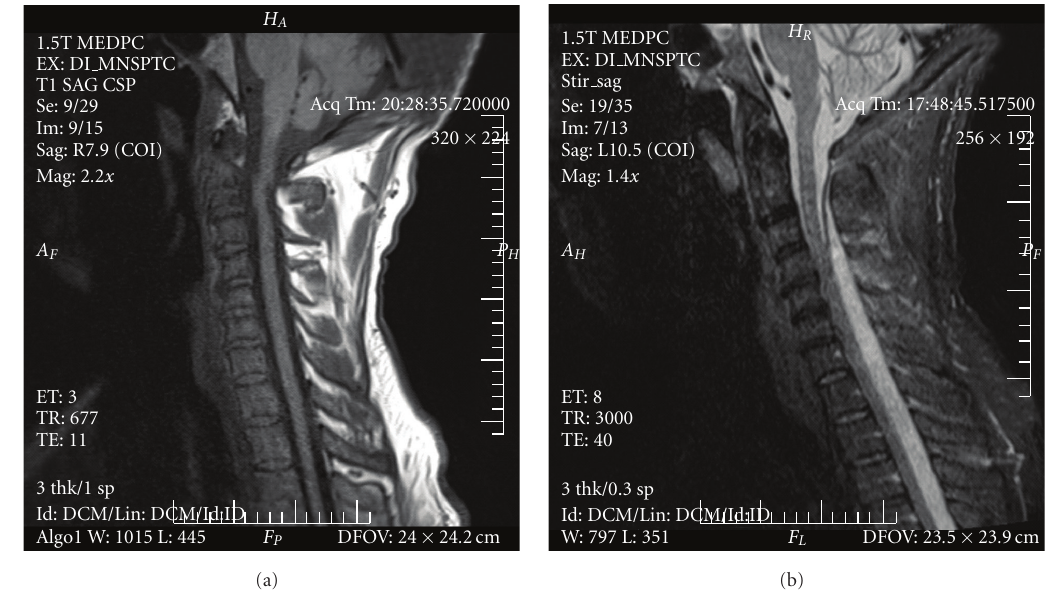
Figure 2: Saggittal T1 cervical spine MRI: day 1 (a) and day 11 (b). Serial MRI images of the cervical spine from hospitalization day 1 (a) and day 11 (b). (a) shows a relatively normal cervical spine with only mild degenerative disc protrusion and mild canal stenosis at C6-C7. (b) shows epidural enhancement and marked anterior compression of the spinal cord beginning at the level of C1 and continuing